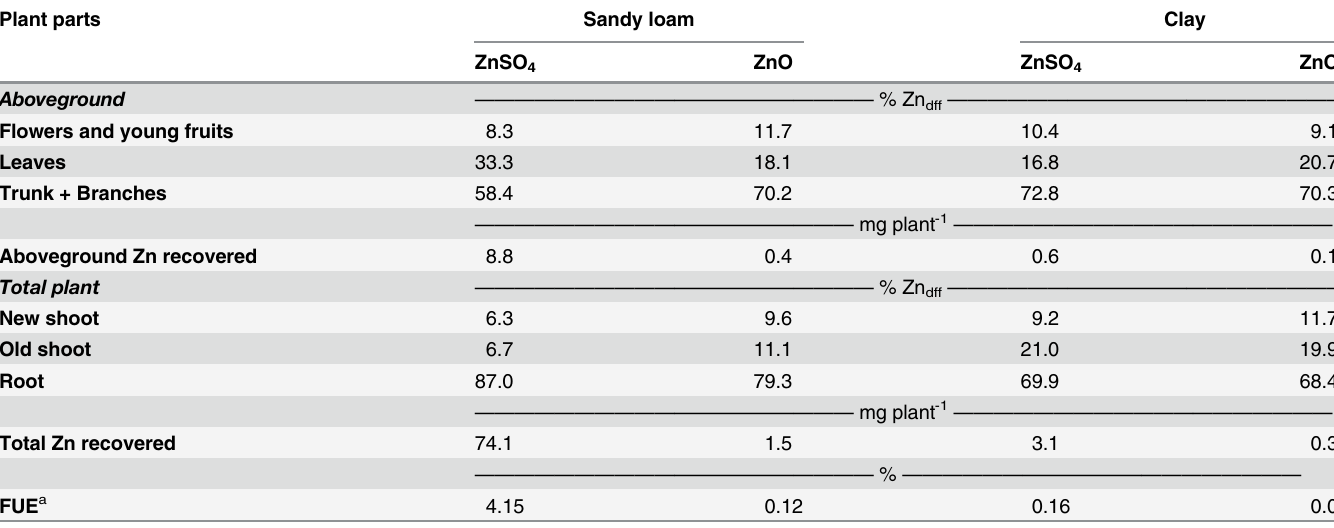
Table 6. Partitioning of Zn derived from fertilizer (PZn dff ) in young orange trees and the FUE of soil-applied Zn. Plant parts